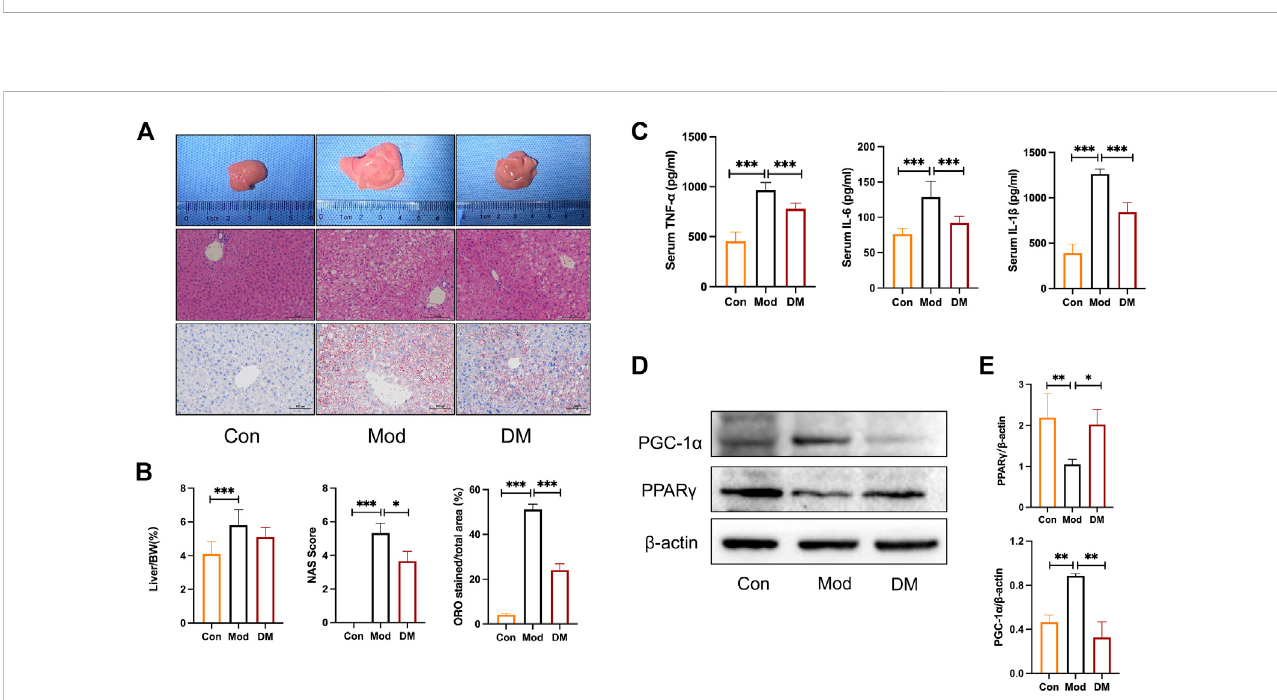
FIGURE 5 (A) Effect of DM on morphology and histopathologic changes in the liver. Representative sections of the liver specimen, H&E staining (scale bars = 100 μ m); (B) DMreducedtheliverweight/BW,NAS,andlipiddropletspercentage(%)intheliver. *p < 0.05 and ***p < 0.001 vs.Modgroupasassessedbyone- way ANOVA with Tukey ’ s multiple comparison test. (C) The effect of DM on serum TNF- α , IL-1 β , and IL-6 (pg/mL), ***p < 0.001 vs. Mod group as assessed by one-way ANOVA with Tukey ’ s multiple comparison test. (D) Western blot images ( n = 3 individual experiments); (E) their statistical analysis of protein expressionsofPPAR γ andPGC-1 α inlivertissue. *p < 0.05 and **p < 0.01 vs.Modgroupasassessedbyone-wayANOVAwithTukey ’